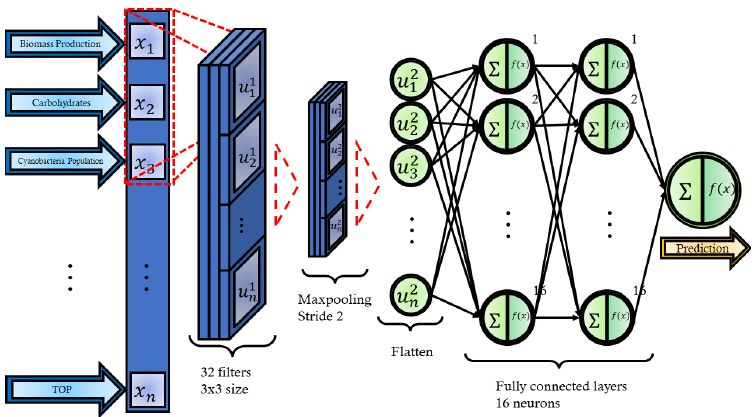
Figure 3. The Convolutional Neural Network scheme